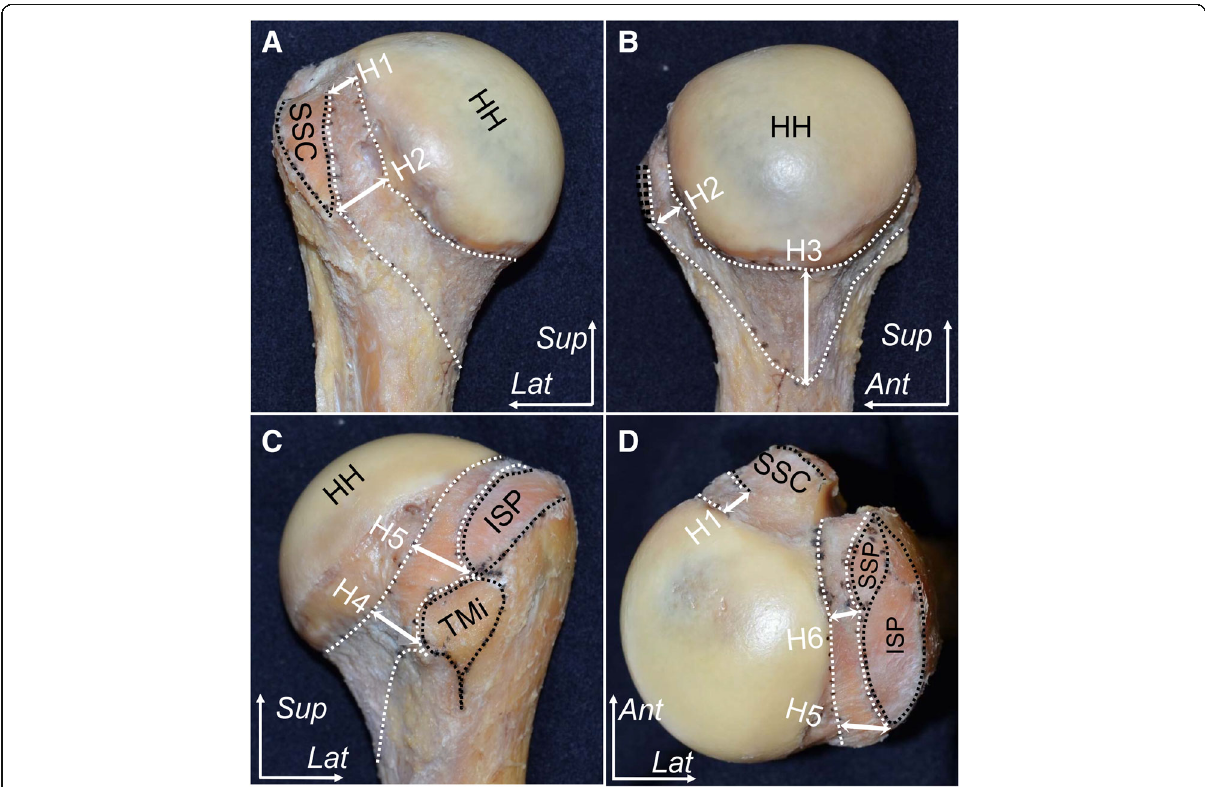
Fig. 5 Humeral attachments of the articular capsule. The area marked with white dotted lines indicates the attachment area of the articular capsule. a Anterior aspect of the humerus. b Medial aspect. c Posterior aspect. d Superior aspect. Attachment widths were measured at superior edge of the subscapularis insertion (H1), the inferior edge of the subscapularis insertion (H2), the widest attachment at the axillary pouch (H3), the inferior edge of the tendinous insertion of teres minor (H4), the border between the infraspinatus and teres minor insertion (H5), and the posterior edge of the supraspinatus insertion (H6). Measurement data are listed in Table 2. HH, humeral head; ISP, insertion of infraspinatus; SSC, insertion of subscapularis; SSP, insertion of supraspinatus; TMi, insertion of teres minor; Ant , anterior; Lat , lateral; Med , medial; Post , posterior; Sup ,